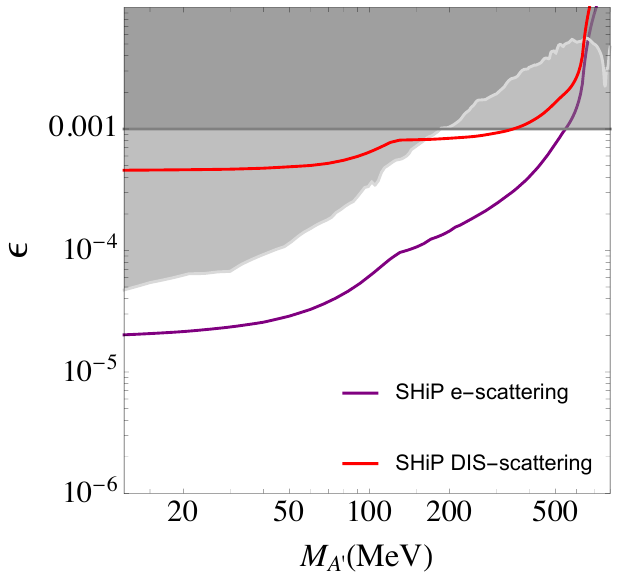
Figure 11. SHiP sensitivity for a Sub-GeV dark photon emitted by rare meson decays of (cid:25) 0 ; (cid:17) and ! obtained with MadDump . For all production modes both electron-DM scattering and DIS are considered considering respectively 284 and 9000 background events. The gray region is excluded by current probes, the strongest are BaBar mono-photon search [51] and MiniBooNE [53]. The dark gauge couplings is chosen to be (cid:11) D = 0 : 5 and the ration between DP and DM mass is